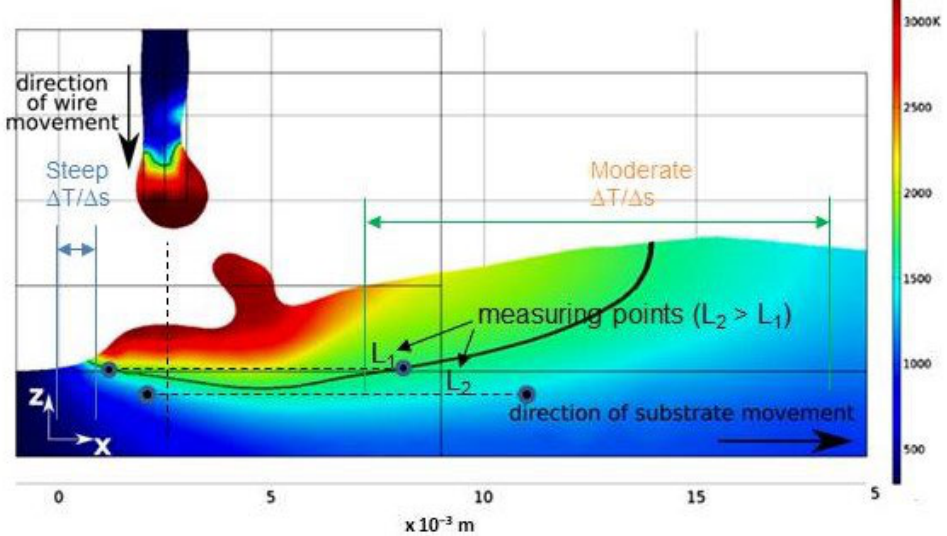
Figure 10. Numerical simulation of a wall deposition by WAAM, showing a steeper isotherm gradient ( ∆ T/ ∆ s) in front of the pool than that at the rear of the pool and the length of homogeneous temperature at positions underneath the pool (information superimposed a figure from Cadiou et al. [18]). Having no influence of the arc on the temperature ahead of the heat source, one can imagine that the temperature profile from the Upper Pyrometer strategy would match the profile with no arc (as illustrated in Figure 11a). The monitored temperature curve would maintain a negative gradient in the direction of the layer deposition. Under the Sideward strategy, in turn, the presence of the electric arc would affect the monitored temperature according to the “L” distances (Figure 11b). The heat arc influence can even make up the natural falling temperatures along the deposited layer